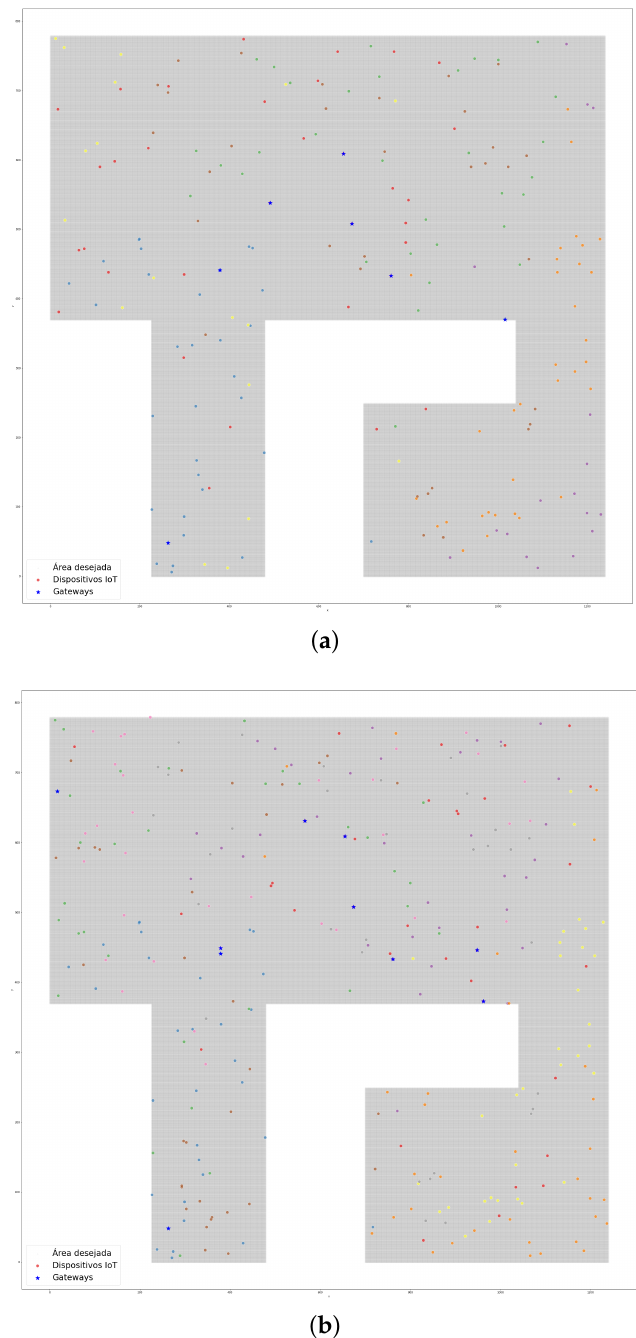
Figure 8. The plots of the devices and their gateways (LoRa technology; outdoor environment): ( a ) the Samambaia Campus with 200 devices and 7 gateways; ( b ) the Samambaia Campus 300 devices and 10